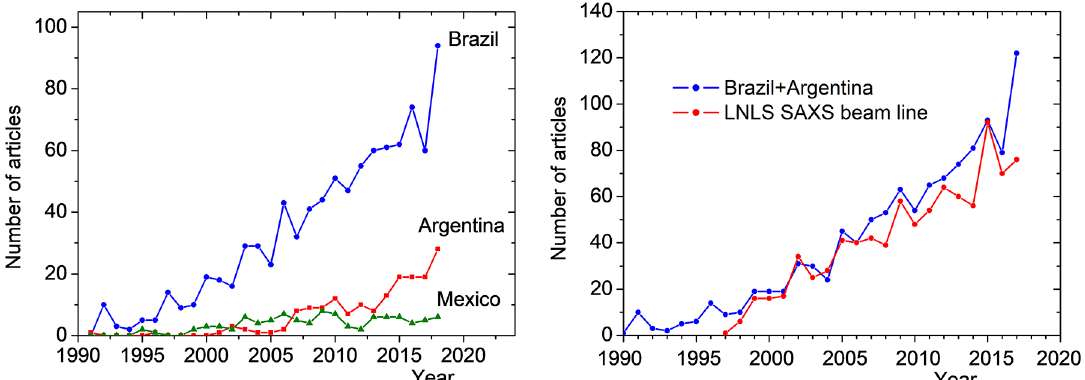
Figure 6. (right) Historical evolution of the annual numbers of articles related to SAXS published by authors from three Latin-American countries (Brazil, Argentina, and Mexico). The annual numbers of articles related to SAXS published by authors from other Latin-American countries are much lower, (left) Added annual numbers of articles related to SAXS published by authors from Brazil and Argentina. Blue symbols: Numbers determined by our Web-of-Science search procedure. Red symbols: Numbers determined by independent counting of published articles containing results from experiments using the LNLS SAXS beam